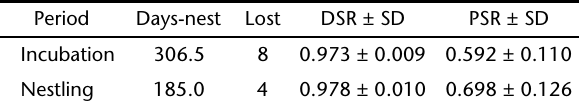
Table I. Mean ± standard deviation (SD) of the daily survival rate (DSR) and period survival rate (PSR) of P. superciliaris . Days-nest corresponds to the number of days a nest was active. Lost corresponds to the number of eggs and nestlings lost during the study period.